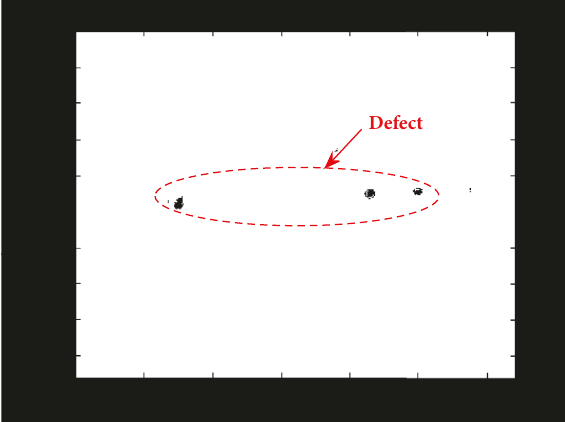
Figure 21: The defect feature of final result.